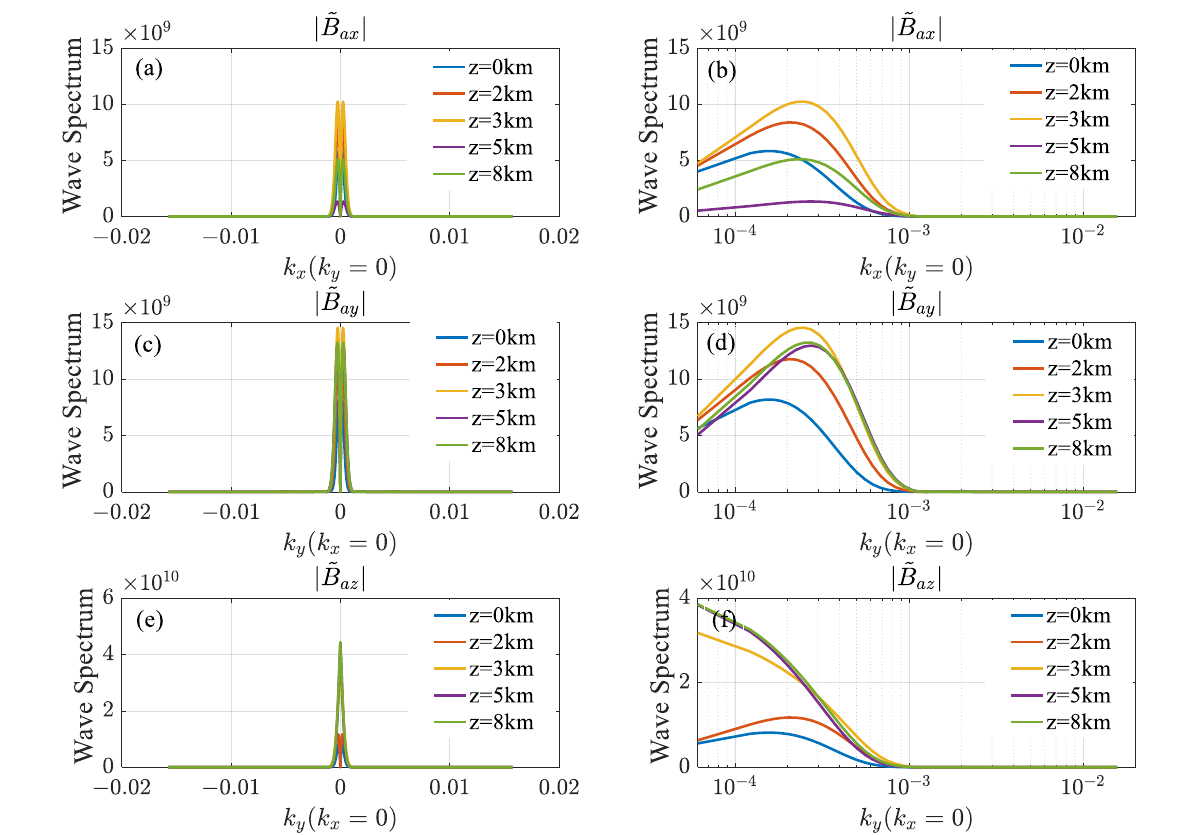
Figure 7. Spectrum distribution of anomaly field at different depths. The horizontal ordinate of figures ( a , c , e ) is non-logarithmic, and the horizontal ordinate of figures ( b , d , f ) is logarithmic. The numerical simulation results based on Gauss-FFT (4 Gaussian points) with 201 × 201 × 101 sampling points were used as a reference to measure the calculation accuracy of the AS-FT algorithm when different mesh divisions and wavenumbers were selected.